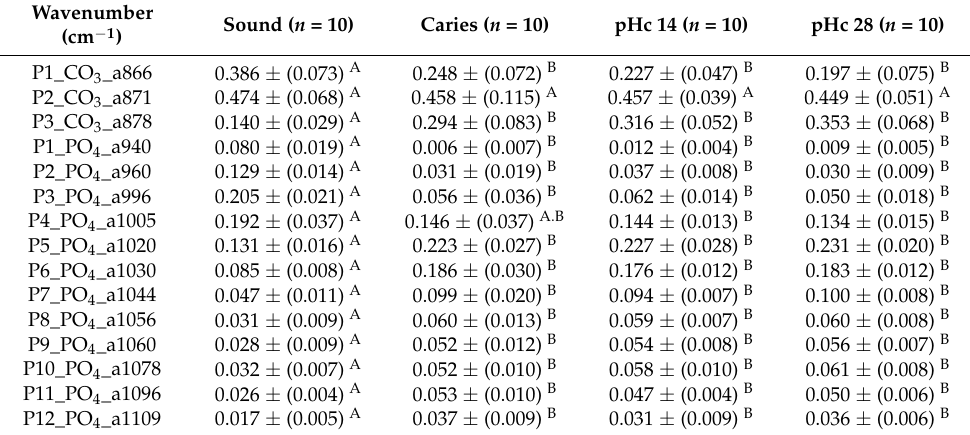
Table 1. Mean and standard deviation (SD) of relative areas for peaks in carbonate ( v 2 CO 32 − ) and phosphate ( v 1 , v 3 PO 43 − ) ATR-FTIR absorption bands. Different superscript capital letters show statistical differences among groups ( p <